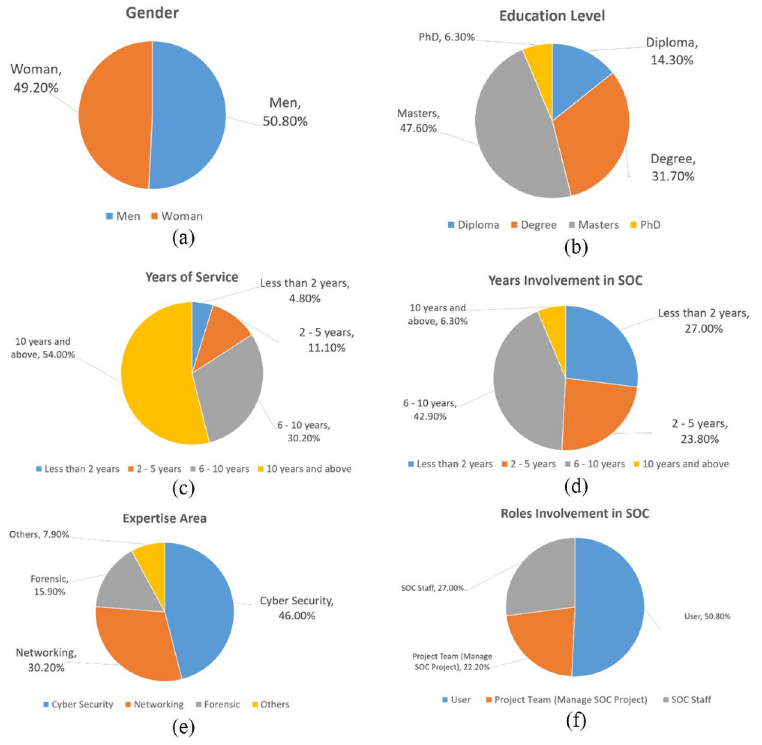
Fig 2. Compilation of general information of respondents. (a) gender group; (b) education level; (c) year of service in the agency; (d) experience with SOC; (e) expertise of the respondent; and (f) roles in SOC.